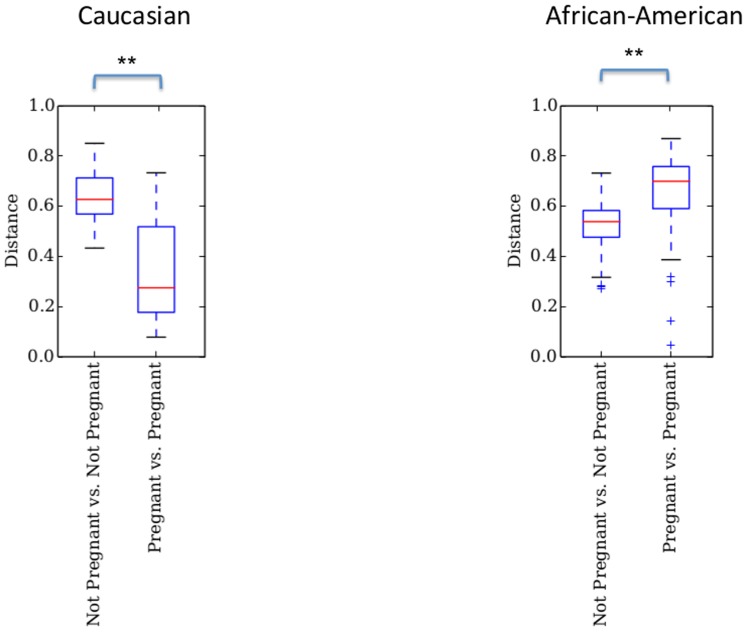
Unweighted Unifrac beta-diversity between pregnant and non-pregnant subjects within each ethnicity.Caucasians show significant convergence as a result of pregnancy (results confounded by platform effects – See Table S1) while African-Americans show significant divergence in pregnancy when compared to non-pregnant subjects. **p<0.001, Monte Carlo analyses, 999 permutations.